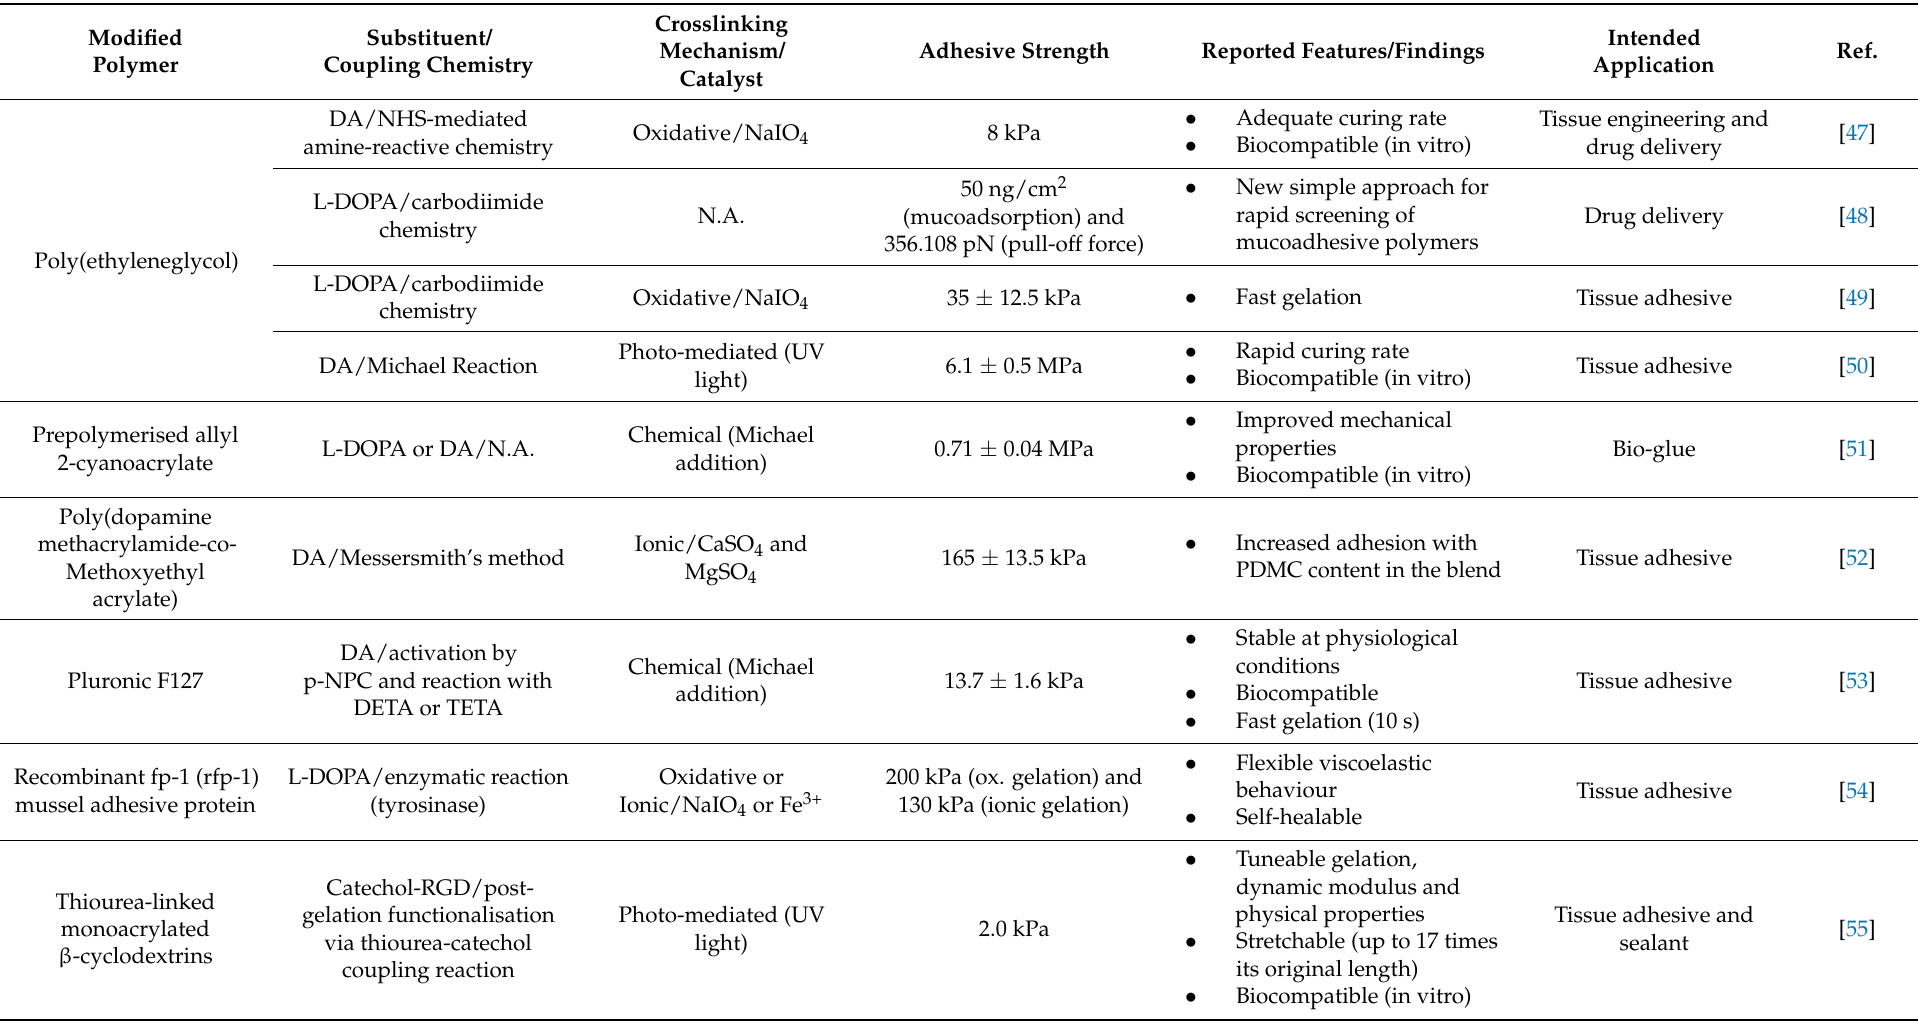
Table 4. Studies involving synthetic polymers, selected for